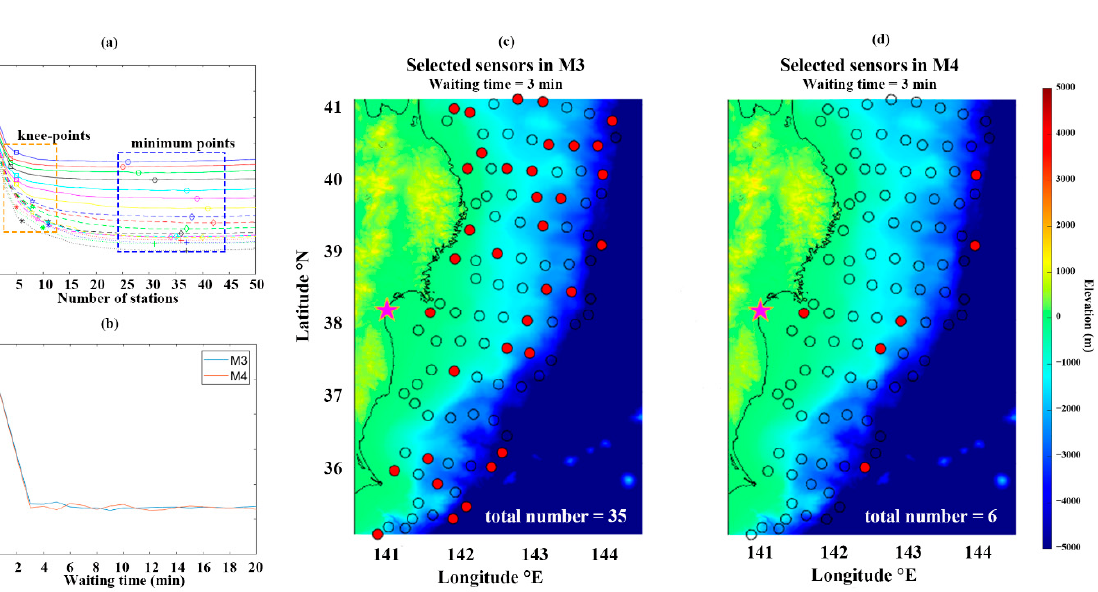
Figure 9. Results of the hazard-based early warning model for Iwanuma: ( a ) AIC score plot, ( b ) MSE–waiting time plot, ( c ) optimal sensor map for M3, and ( d ) optimal sensor map for M4. The pink star represents the target location (Iwanuma). The red and empty circles represent the selected and unselected sensors, respectively.